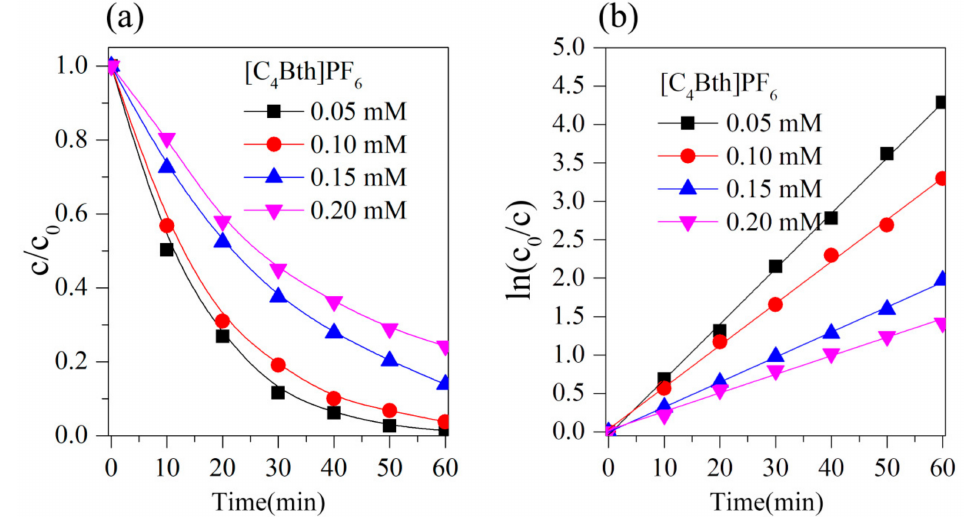
Figure 3. E ff ect of concentration of initial concentration of ionic liquids (ILs) on degradation ( a ); e ff ect of initial concentration of ILs ( b ) on kinetic constant; t = 45 °C, pH = 5.06, [H 2 O 2 ] = 100